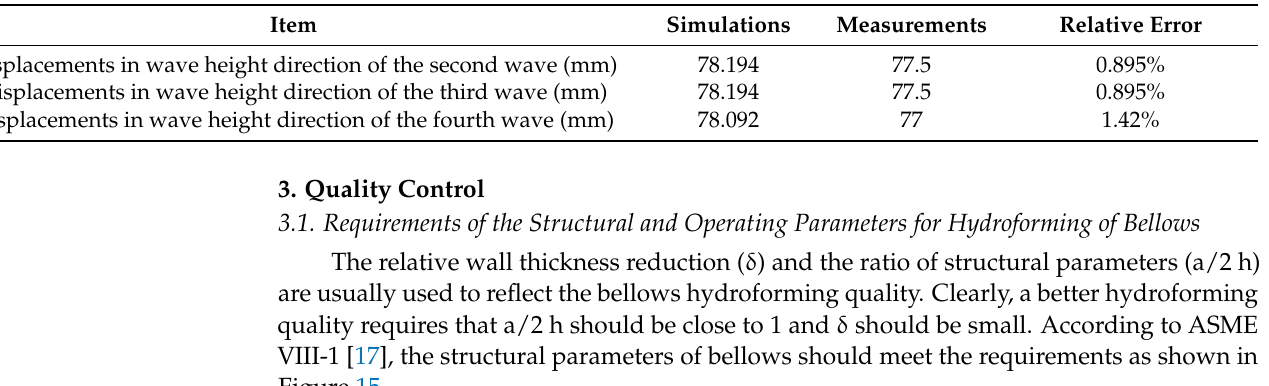
Figure 16. Dimensions of bellows in engineering practice.